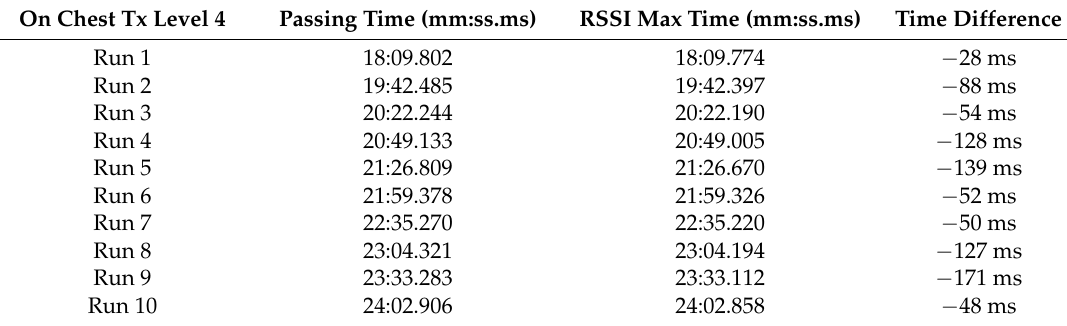
Table 3. The dynamic experiment when the Tx power of the BLE Tag on the chest is set at Level 4. On Chest